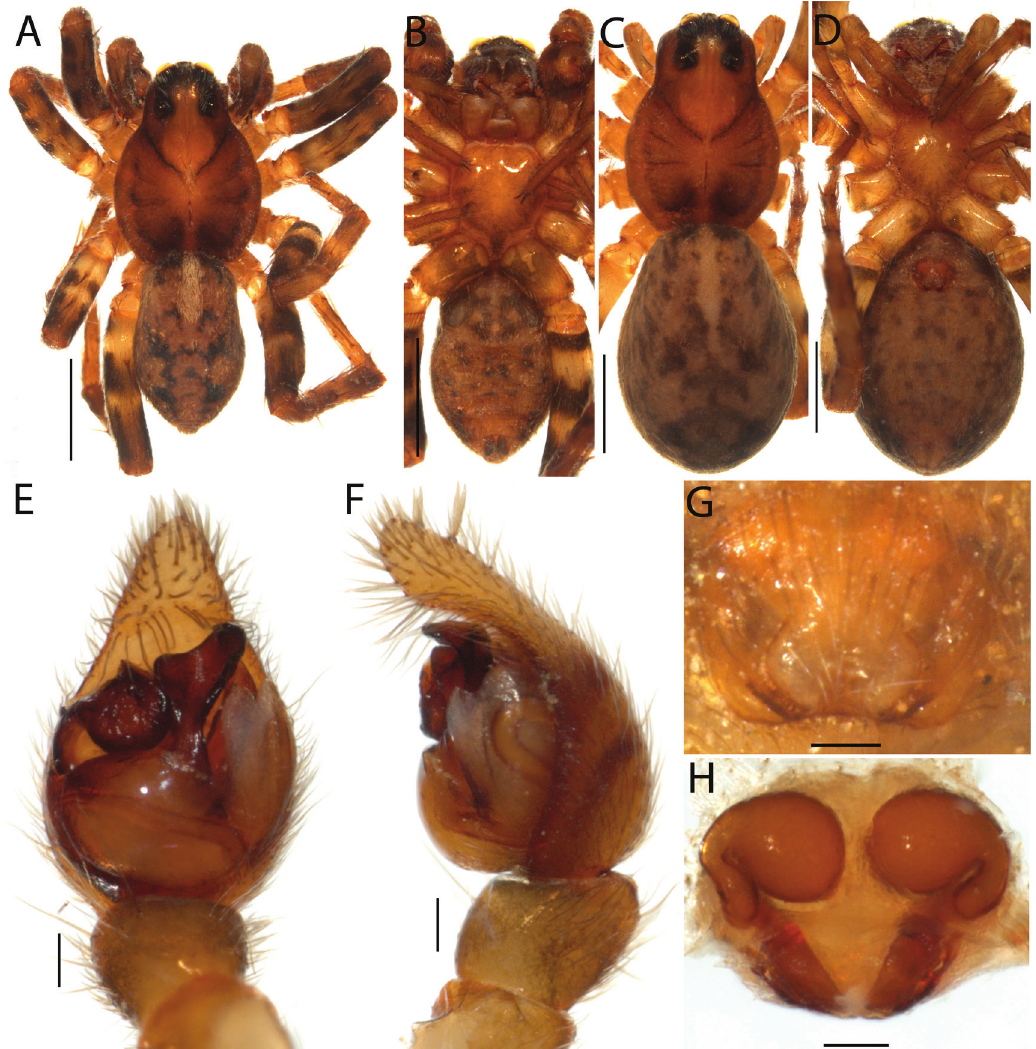
Figure 7. Artoria beaury sp. n., male holotype (AM KS127757), female paratype (AM KS51053): A , male habitus, dorsal view; B , male habitus, ventral view; C , female habitus, dorsal view; D , female habitus, ventral view; E, male pedipalp, ventral view; F , male pedipalp, retrolateral view; G , epigyne, ventral view; H , epigyne, dorsal view. Scale bars: habitus 1.0 mm; pedipalp, epigyne 0.1